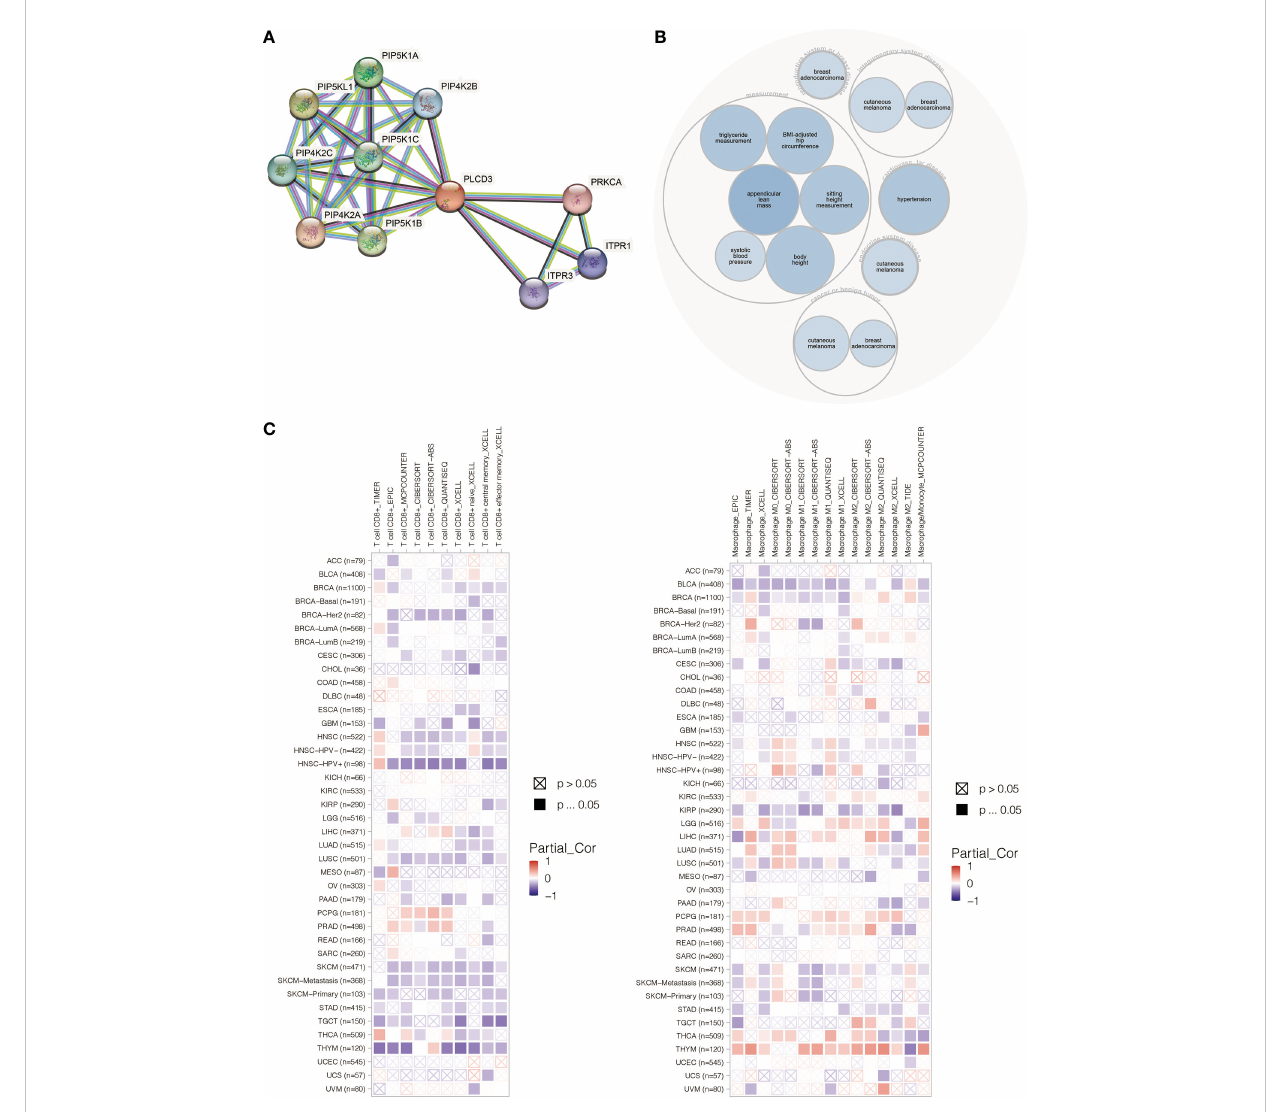
FIGURE 11 (A) The PLCD3 protein interaction network. (B) The PLCD3 illness network. (C) PLCD3 ’ s pan-cancer immune in fi ltration